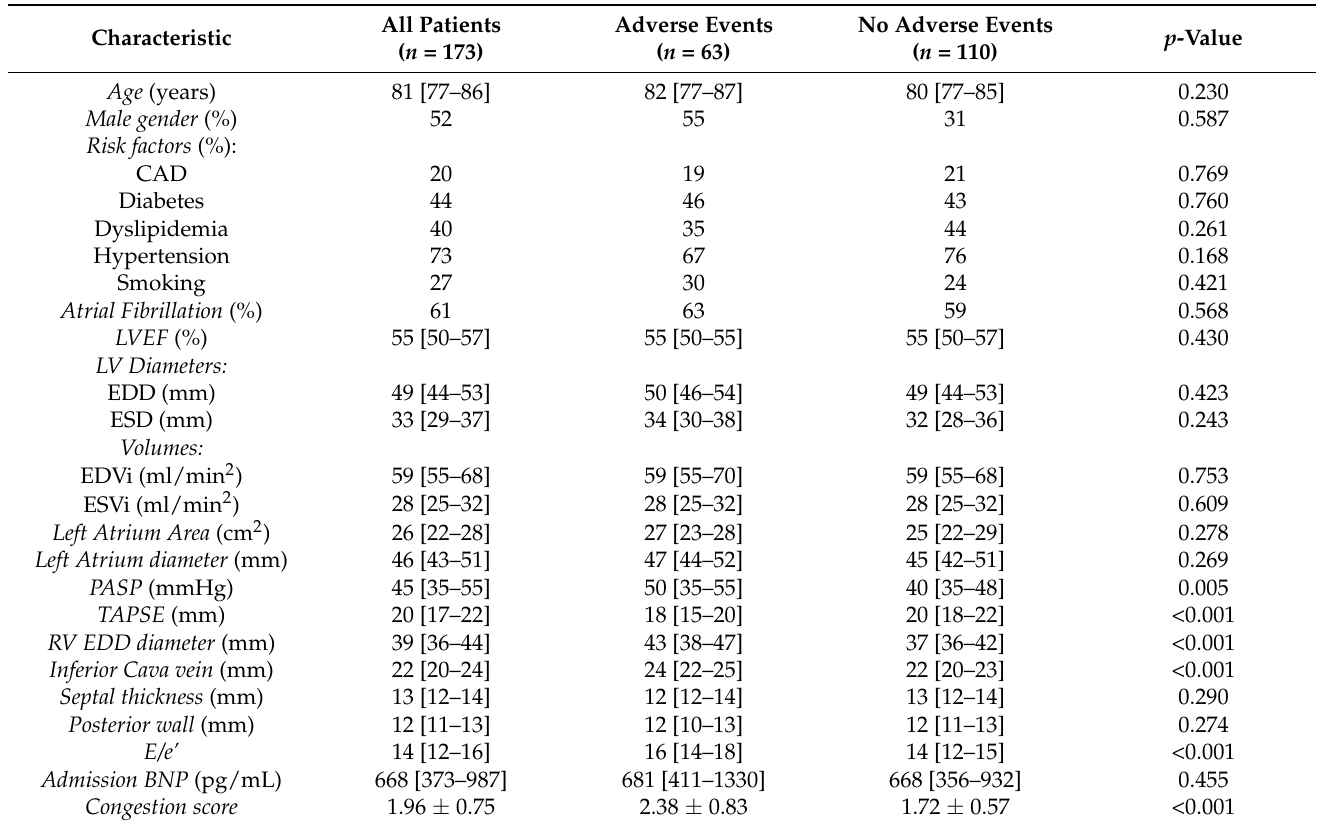
Table 1. Baseline characteristics of our population stratified according to adverse event occurrence.